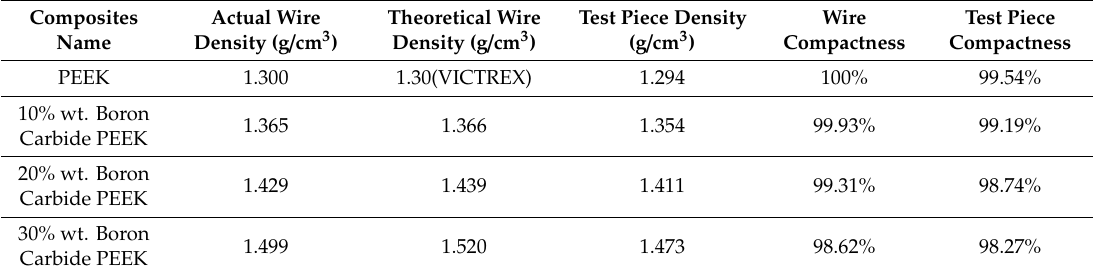
Table 3. Density and compactness of PEEK and boron carbide PEEK